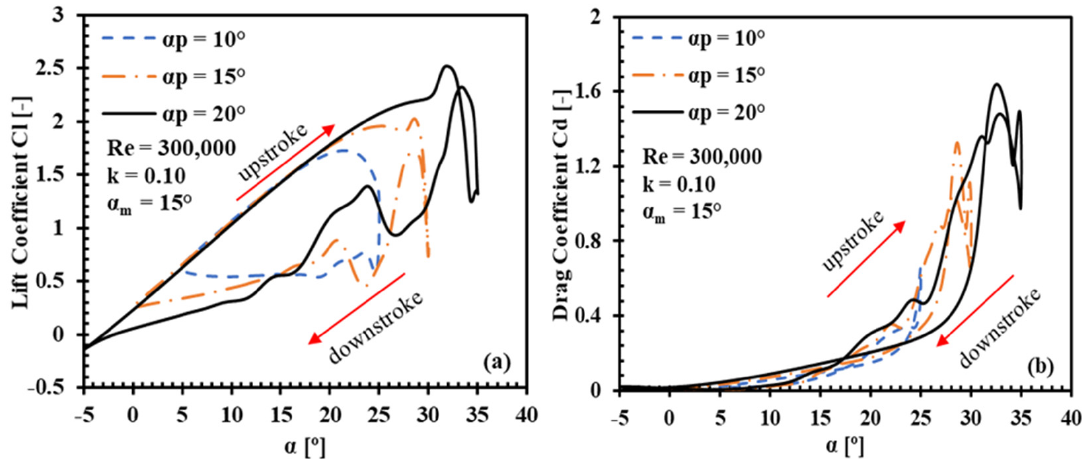
Figure 8. Aerodynamic coefficient curves: ( a ) Cl and ( b ) Cd for oscillation amplitudes α p = 10°, 15°, and 20°.